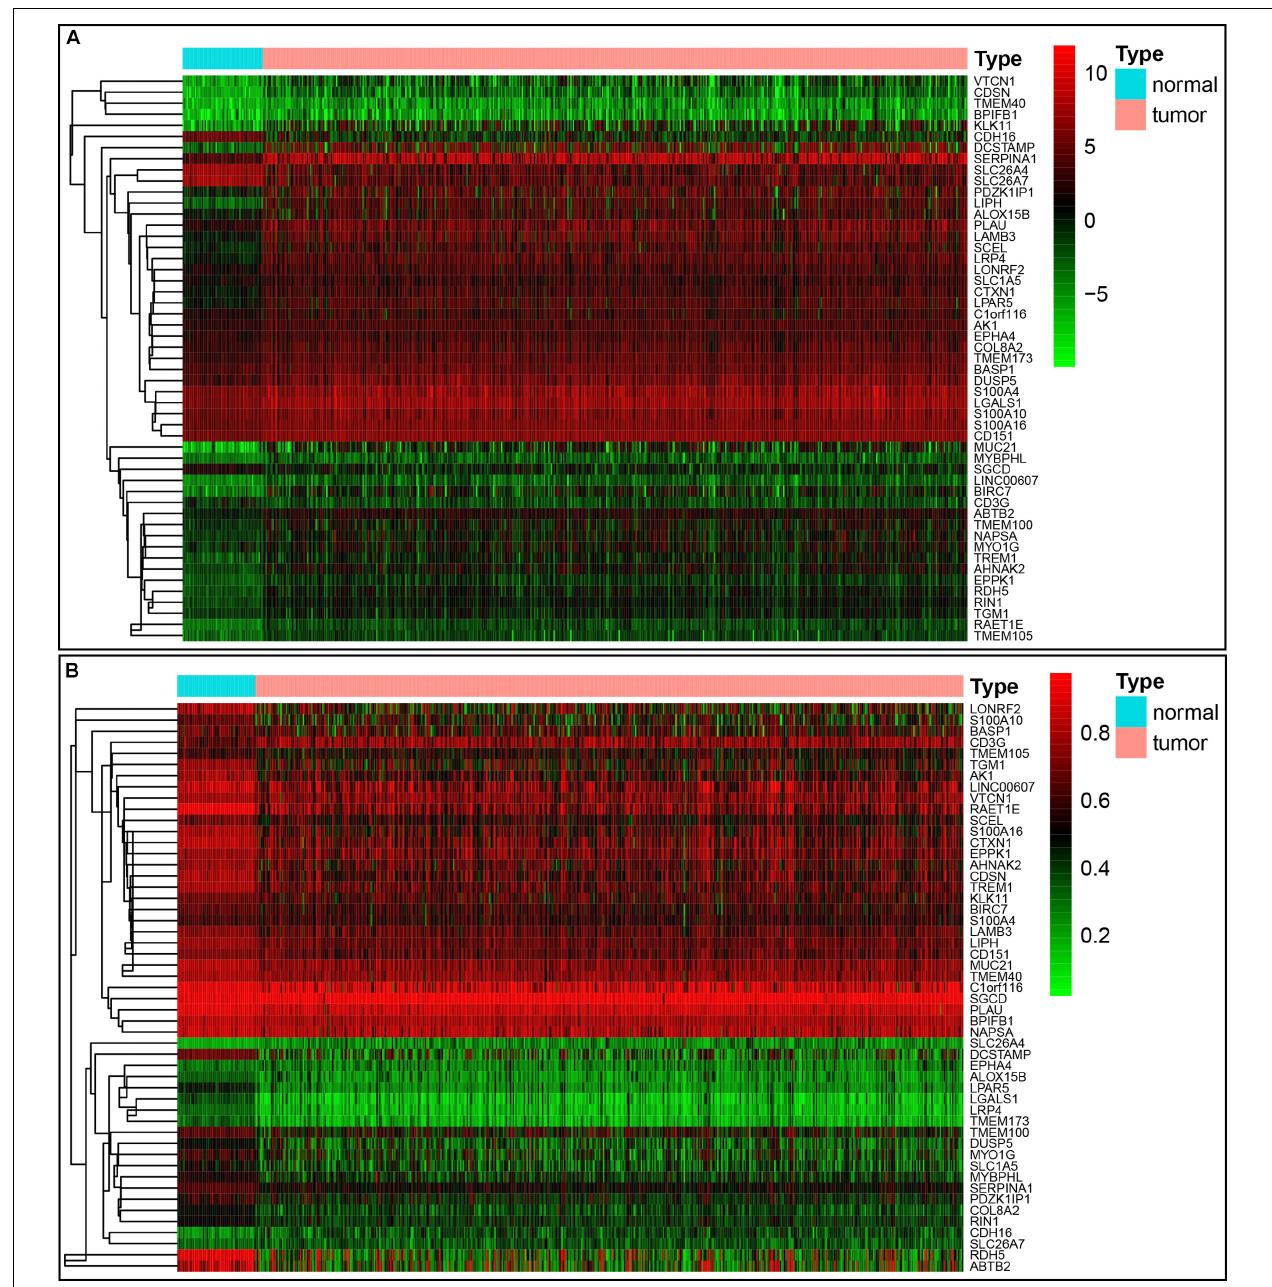
FIGURE 2 | Heatmap of 51 methylation-driven genes in thyroid cancer. (A) The expression pattern of 51 methylation-driven genes. Red represents upregulated genes and green represents downregulated genes between tumor and normal tissues. (B) The methylation pattern of 51 methylation-driven genes. Red represents highly methylated genes and green represents low methylated genes between tumor and normal